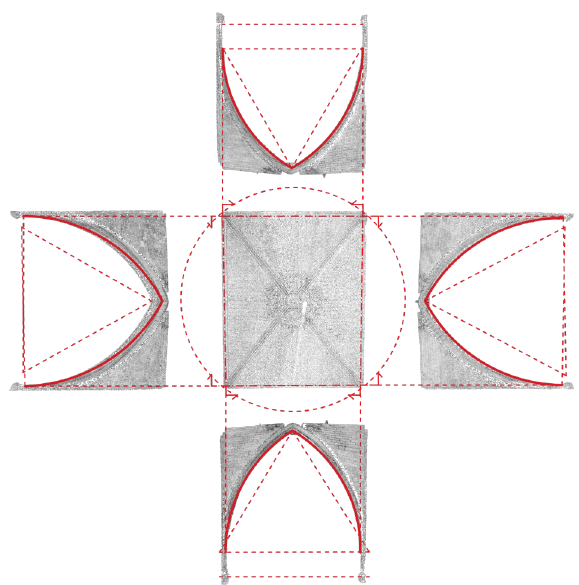
Figure 10 . Definition of curvatures and centres of perimetral arches of one of the vaults of San Miguel.